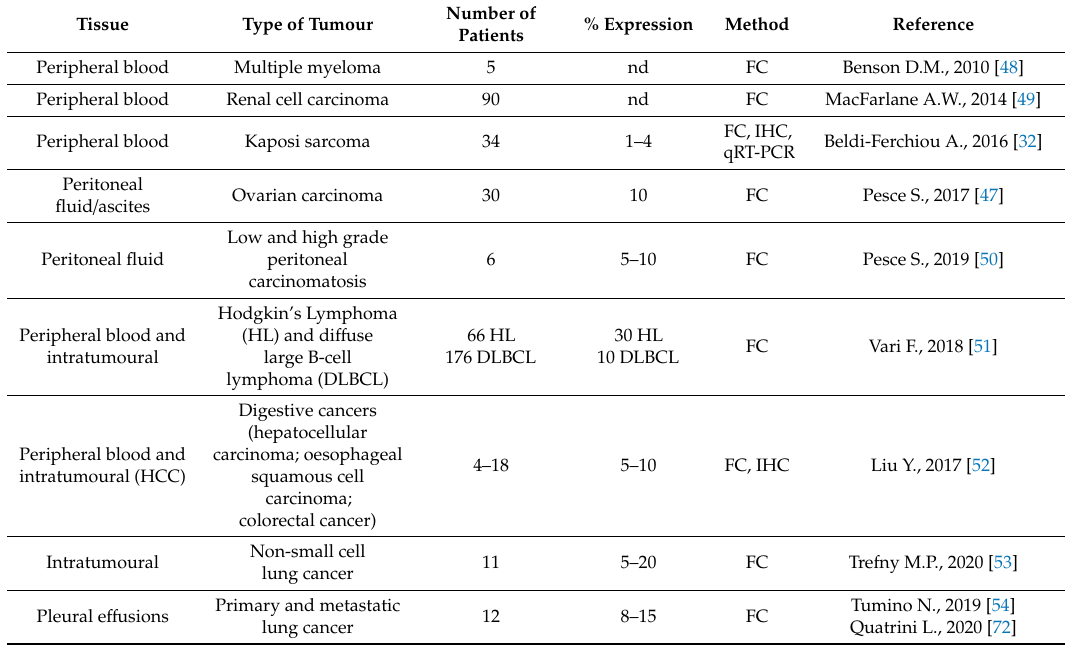
Table 1. Evidence for PD-1 expression on human natural killer (NK) cells in tumours.